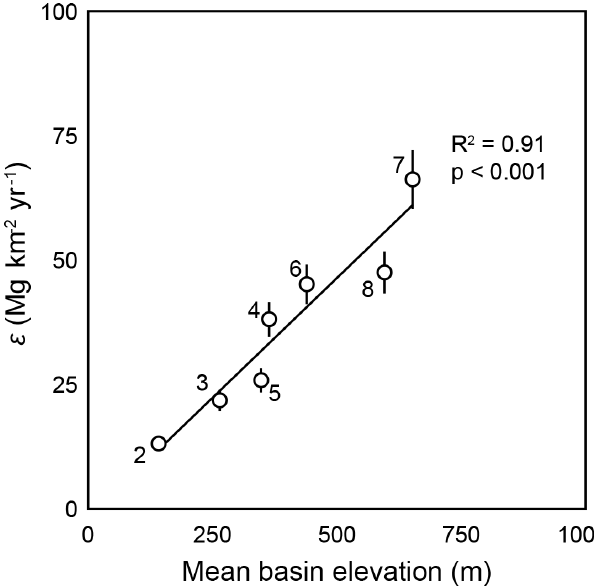
Figure 7. A strong correlation between 10 Be i -based erosion rates ( ε ) and mean basin elevation for the seven tributary samples collected in this study. We do not include trunk-channel sites be- cause erosion rates here also incorporate erosion occurring in tribu- tary